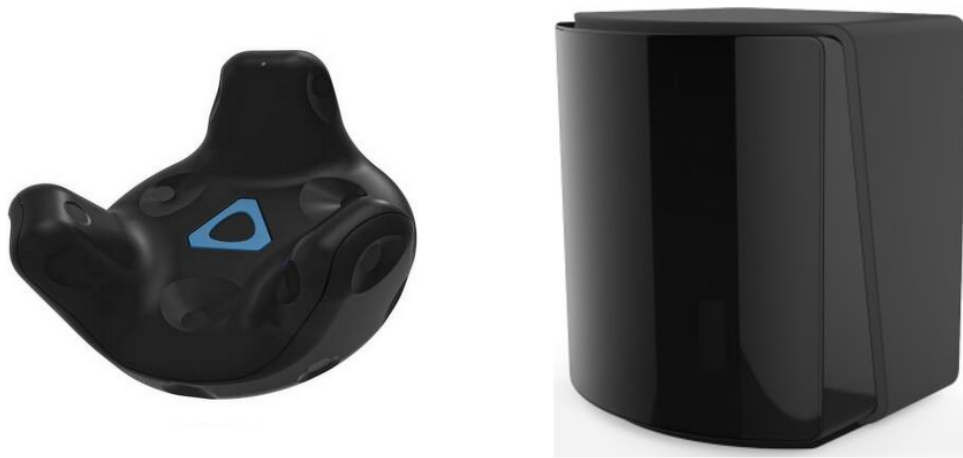
Figure 2. HTC Vive Tracker sensor ( left ) and base station ( right